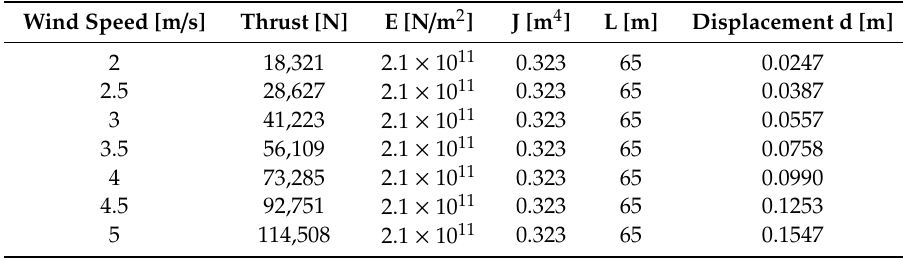
Table 4. Theoretical